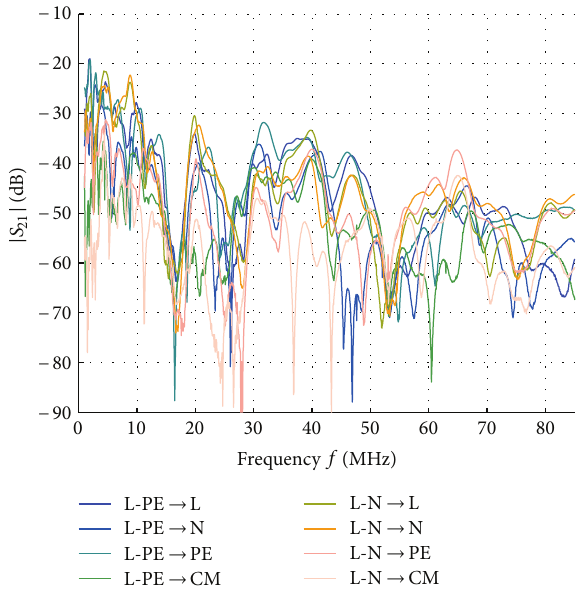
Figure 3: Magnitude of the transfer functions ( 𝑆 21 , forward scatter- ing parameter) of all MIMO paths of a 2 × 4 MIMO